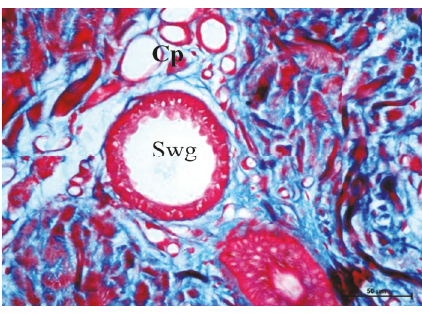
Figure 8: Photomicrographs from abdomen lateral region of skin showing epidermis (E), hair follicle (HF), sweat gland (Swg), and sebaceous gland (Sg). Hematoxylin and eosin X